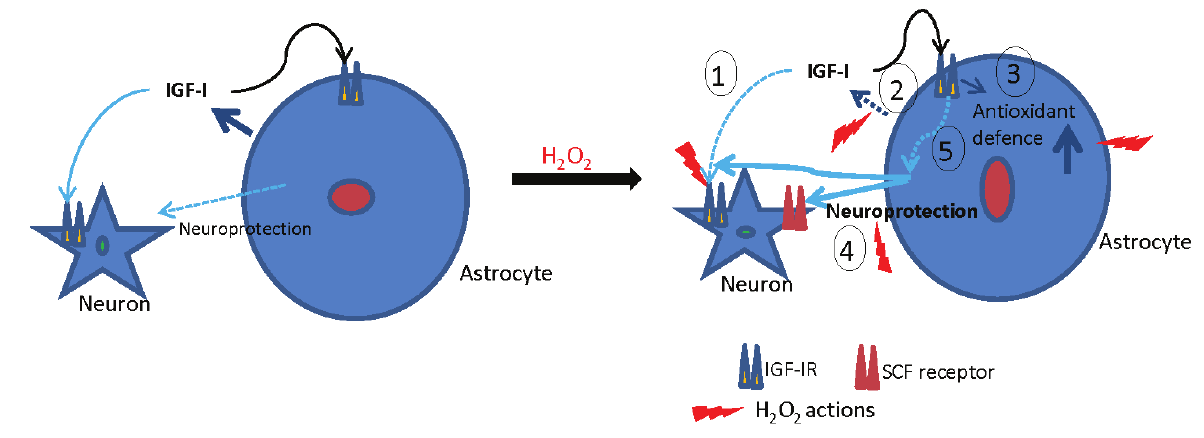
Figure 8. Schematic representation of IGF-I neuroprotection through astrocytes. Left: under basal conditions IGF-I exerts potent neuroprotective actions directly onto neurons, as extensively documented previously 8 (also shown in Figure 3A), and probably also through astrocytes. In the presence of H O (right side) the actions of IGF-I on neurons and astrocytes can be summarized in 5 points: 1) IGF-I 2 2 loses its ability to directly protect neurons, 2) IGF-I secretion by astrocytes is diminished, 3) IGF-I reinforces astrocyte defences against oxidative stress by down-regulating pro-oxidant mechanisms such as TXNIP1. 4) IGF-I cooperates with SCF secreted by astrocytes to promote neuronal survival. 5) However, the precise mechanism(s) downstream of astrocyte IGF-I receptors underlying enhanced astrocyte neuroprotection remains to be determined. Cytotoxic effects are depicted in red while cytoprotective actions are indicated in blue